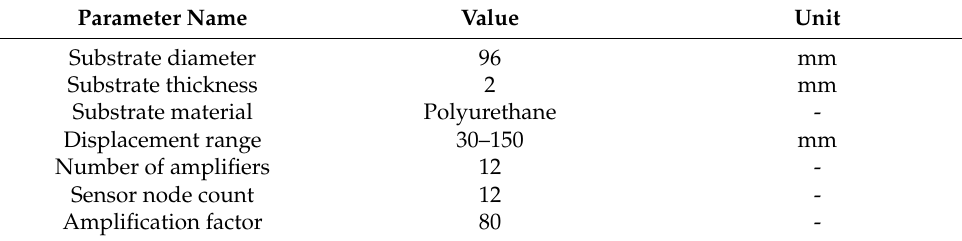
Figure 9. A photo of the smart cup test bed. Note: 1. DC power supply, 2. Digital high shutter speed camera, 3. Motor regulator, 4. Slider-crank mechanism, 5. DC motor, 6. Φ 100 PIG with smart cup, 7. Load cell, 8. DAQ (Data acquisition unit), 9. Drawstring displacement sensor, 10. Load cell transducer, 11. Bridge and amplifier circuit, 12. Spare smart cup. Table 3. Experimental data